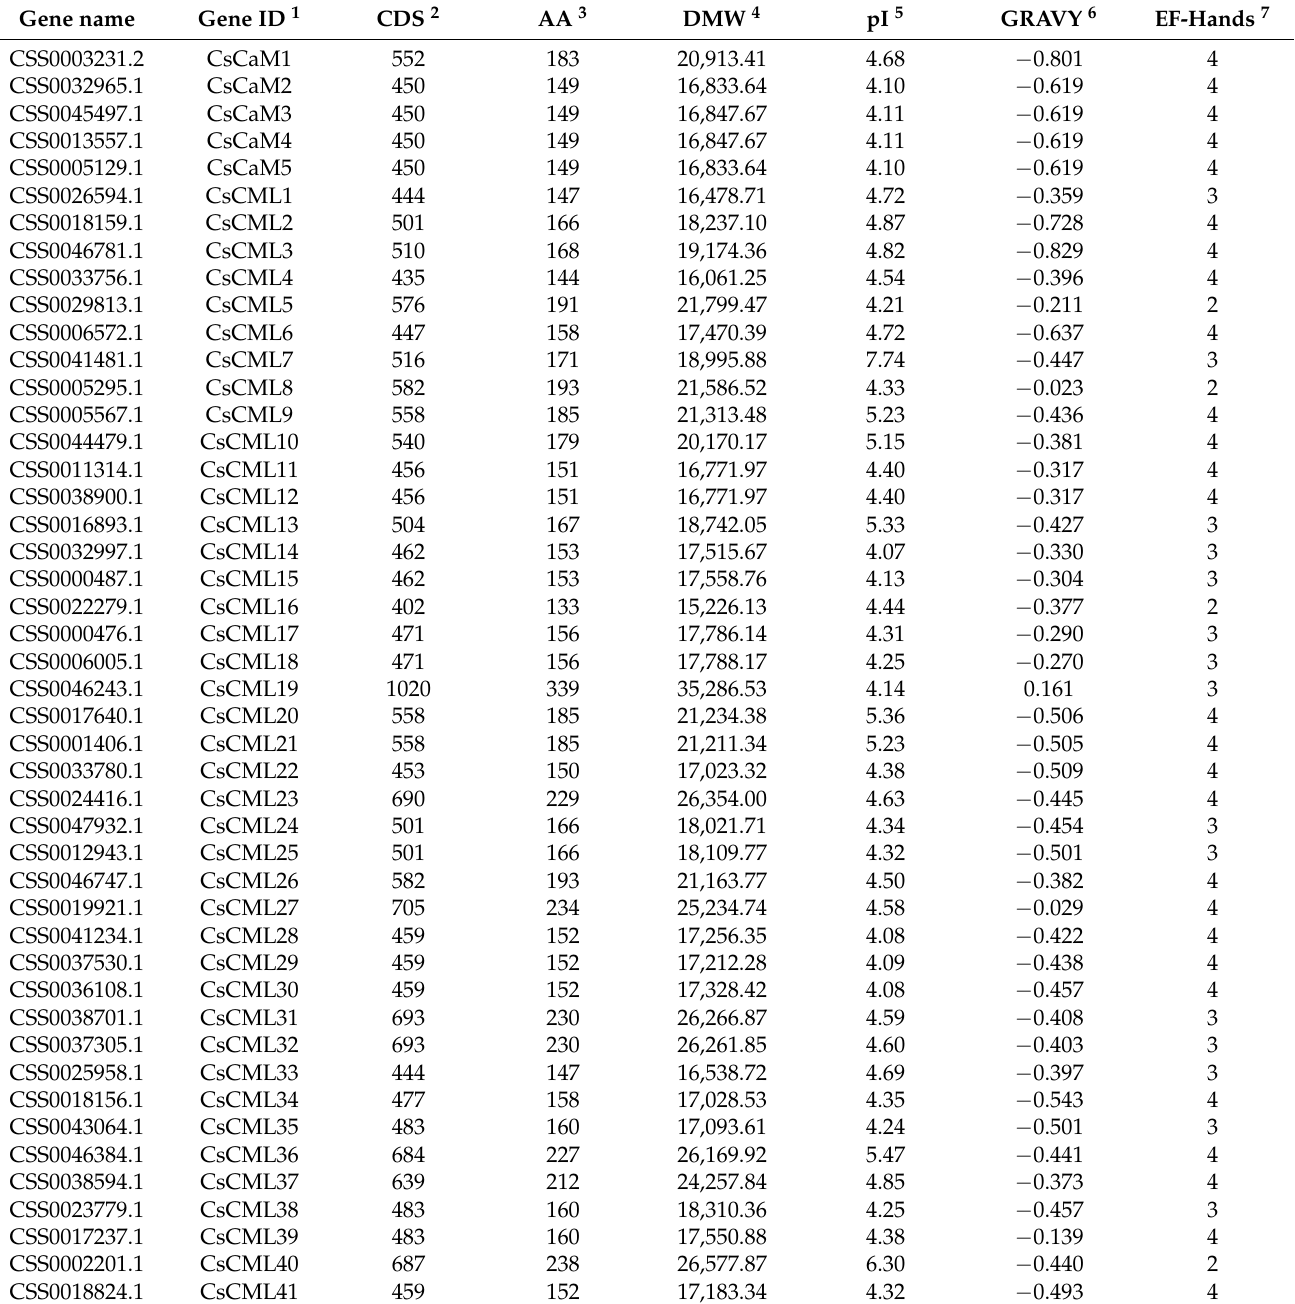
Table 2. Characteristics and names of the CsCaM and CsCML proteins identified in the Camellia sinensis